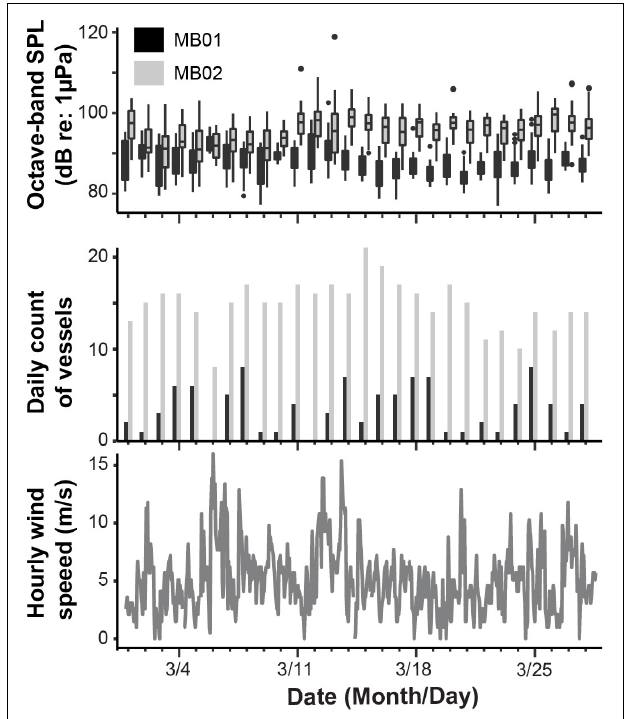
FIGURE 10 | Divergence in sound pressure level at near-by sites. Top panel shows comparison of sound pressure levels (500-Hz octave band) at nearby sites in Monterey Bay National Marine Sanctuary (MB01 and MB02). The sites have different levels of vessel presence (middle panel), measured from all AIS-transmitting vessels within 10 km of each acoustic sensor; the majority of vessels transmitting AIS are in the small category ( < 20 m). Bottom panel shows regional hourly wind speed for